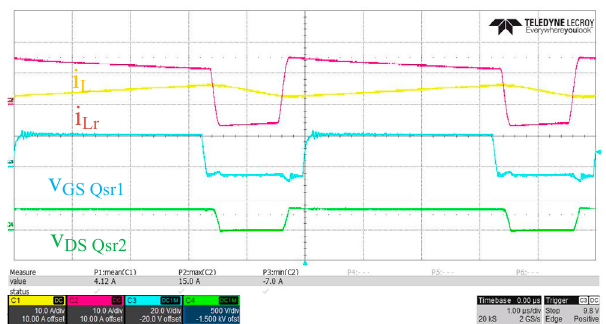
Figure 19. Resonant inductor current and output inductor current waveform, Q sr 1 switch’s v GS signal and Q sr 2 switch’s v DS voltage at V O = 250 V, Io = 4 A (scale i L (Ch1): 10 A/div; i Lr (Ch2): 10 A/div; v GS_Qsr 1 (Ch3): 20 V/div; v DS_Qsr 2 (Ch4): 500 V/div; time: 1 µ s/div).